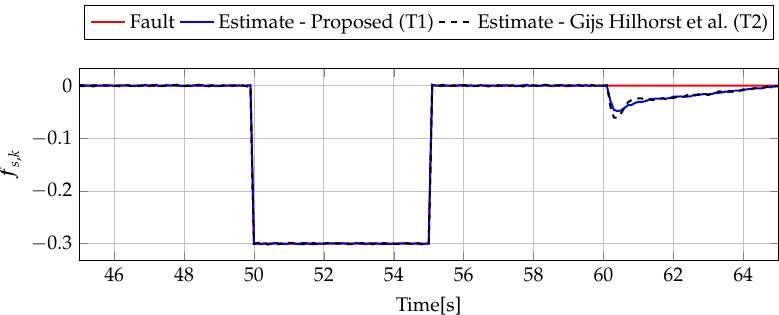
Figure 8. Fault f (red line) and fault estimate obtained with Theorem 1 (T1) and Theorem 2 (T2) s , k based on [39] for FS2 (for t = 45, . . . ,65 [s]) as well as the response for disturbance signal w 1, k .